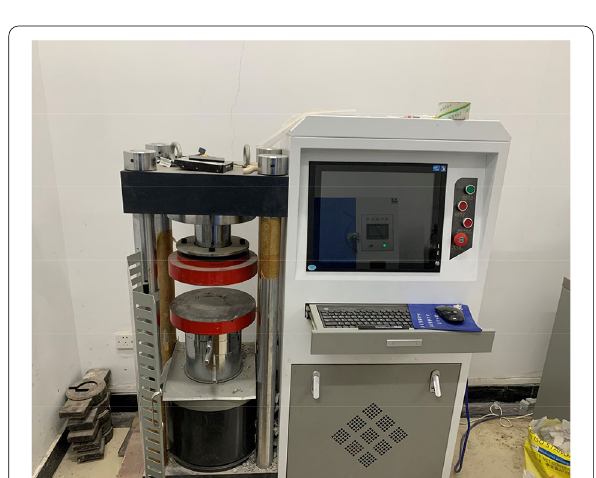
Fig. 4 Mechanical testing